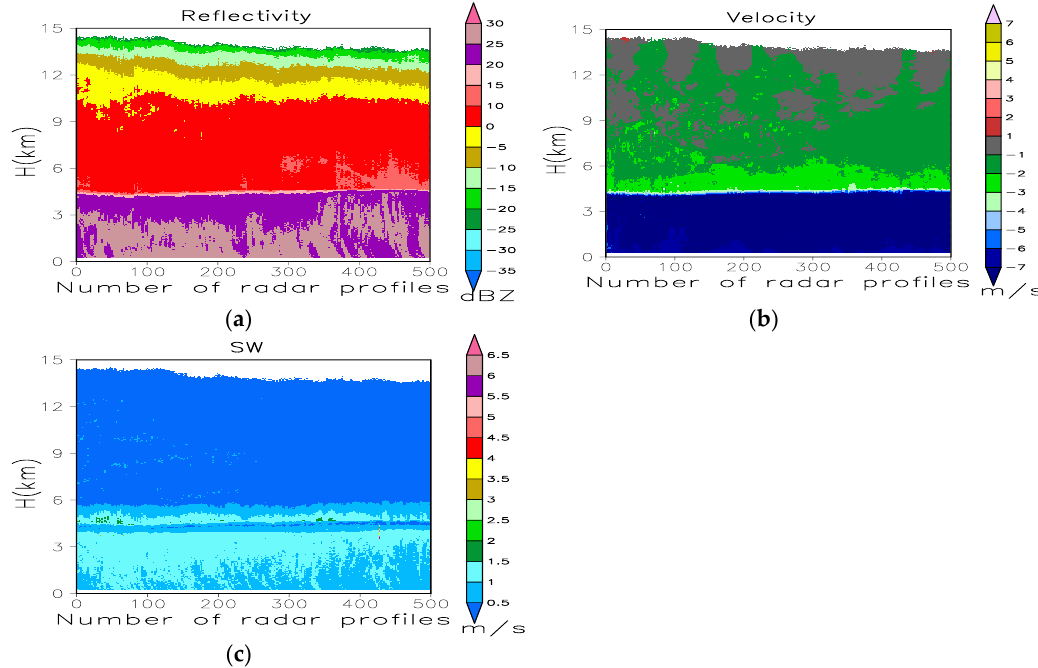
Figure 10. Merged ( a ) reflectivity, ( b ) velocity, and ( c ) spectral width from the three moments of Doppler spectra observed using the three models with the previous algorithm.